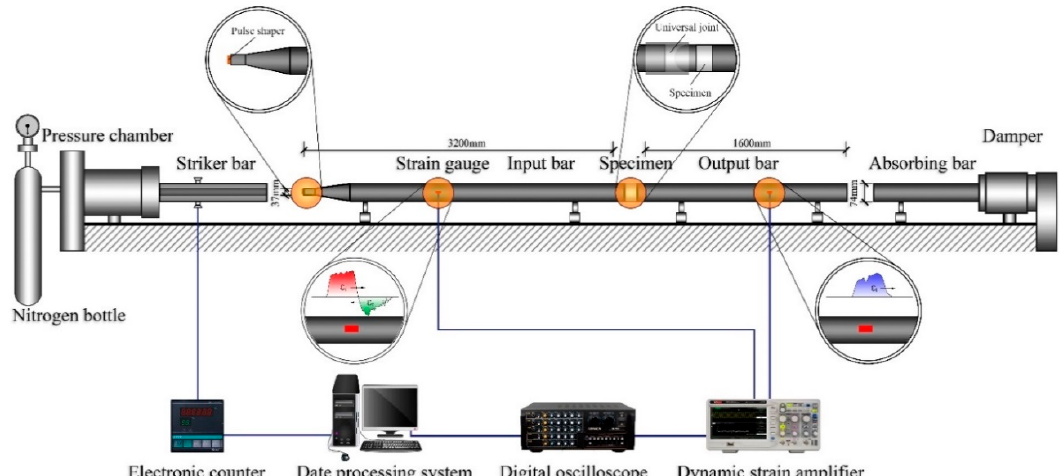
Figure 6. Schematic illustration of SHPB apparatus.